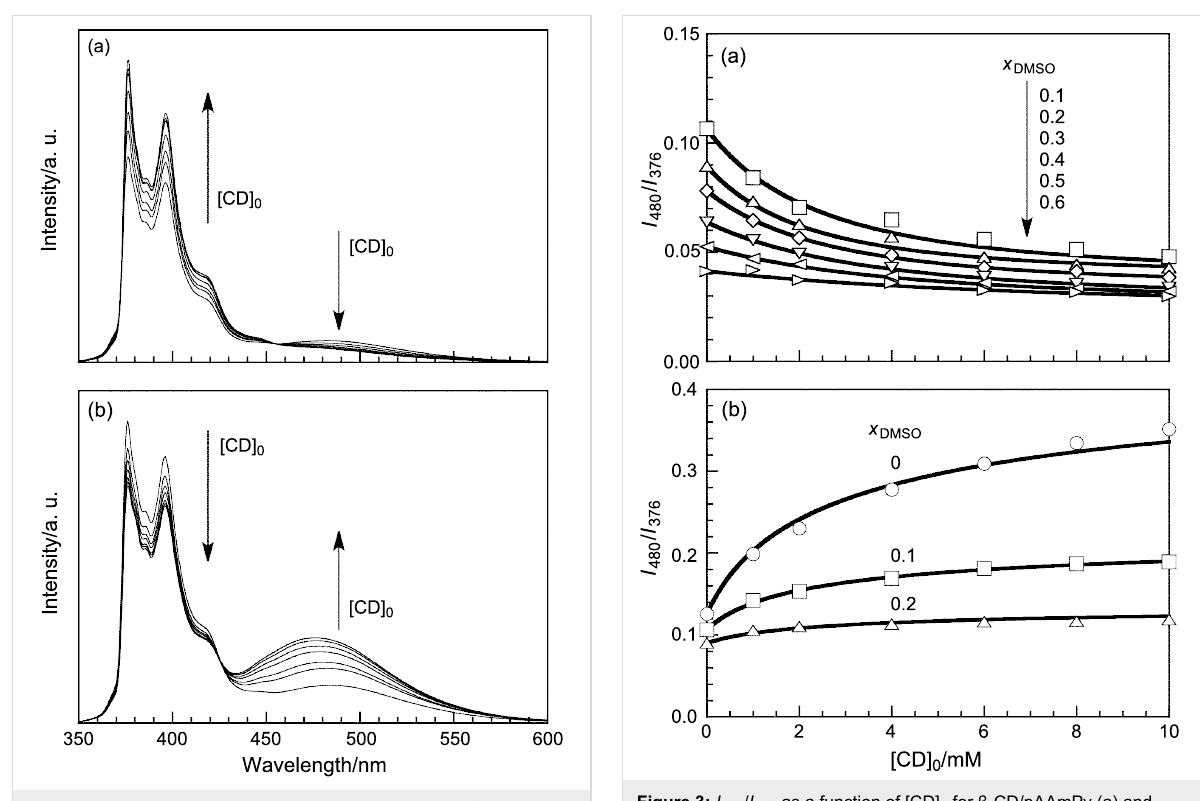
Figure 2: Steady-state fluorescence spectra for 0.04 g L − 1 pAAmPy with excitation at 335 nm in the presence of varying concentrations of β -CD at x DMSO = 0.1 (a) and of γ -CD at x DMSO = 0 (b).